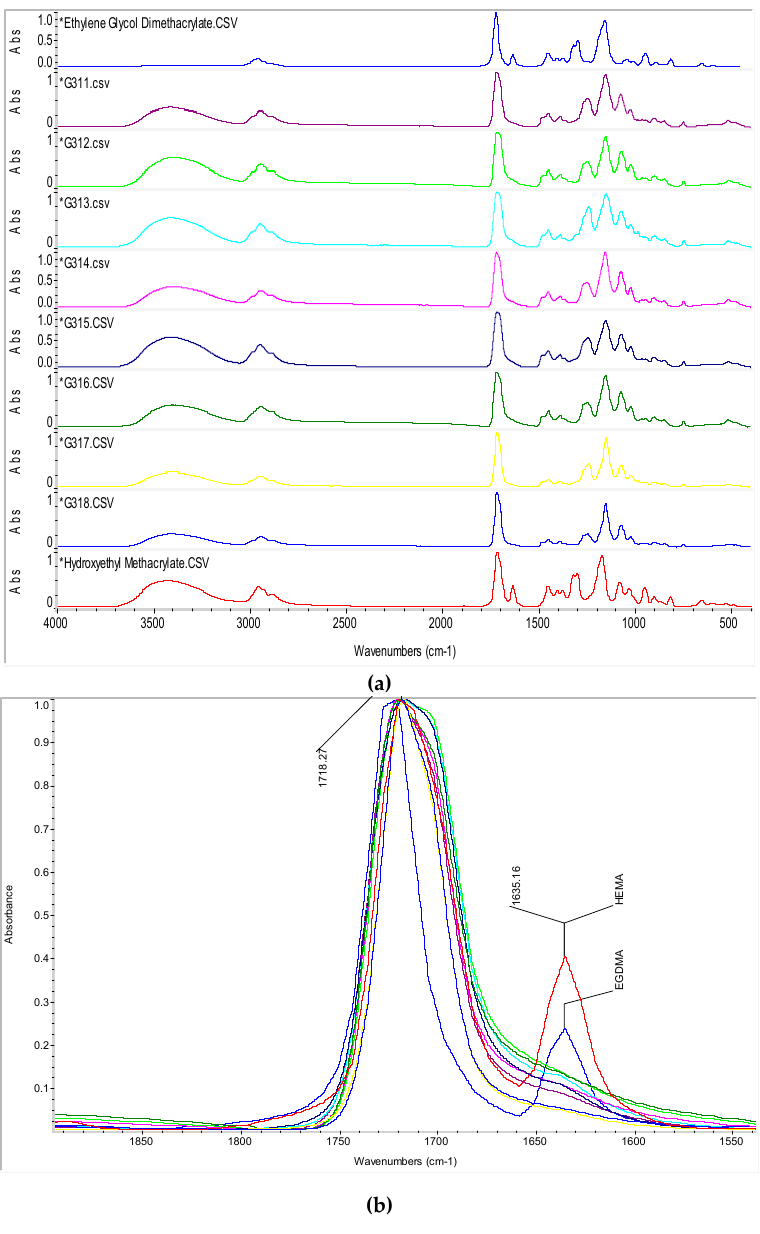
Figure 7. FTIR spectra ( a ) and enlarged view of the region of interest ( b ). Table 4. Assignment of functional groups to bands of the FTIR